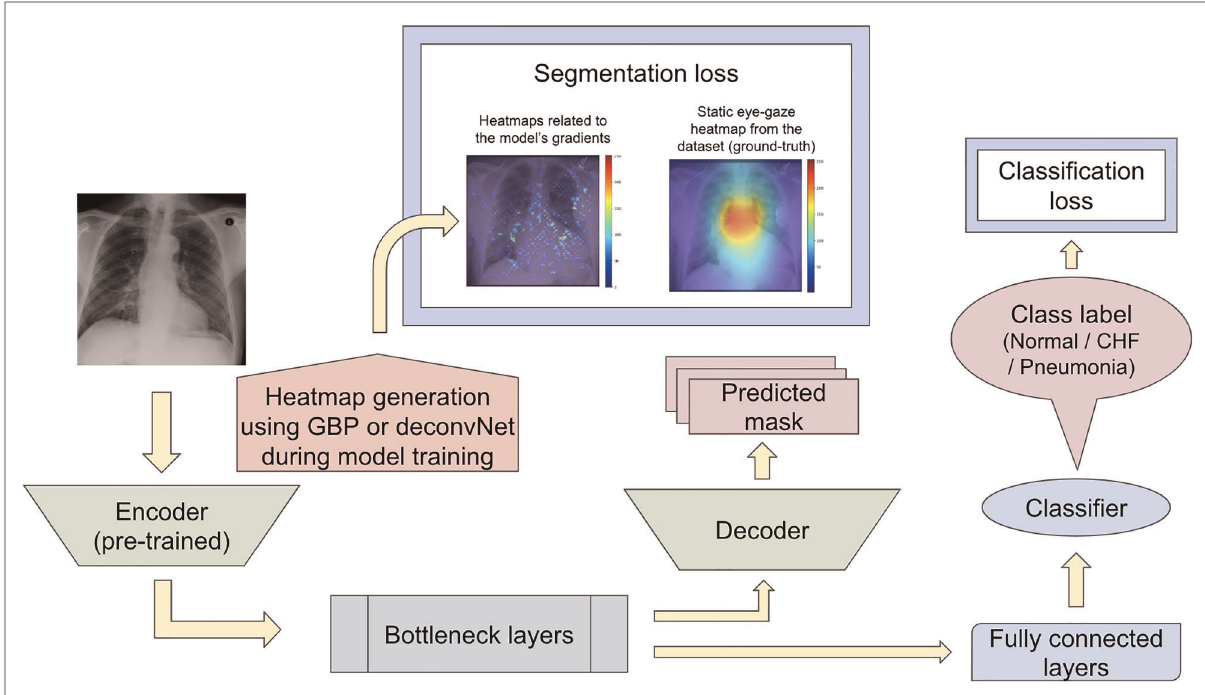
FIGURE 6 Model architecture for the proposed model set 1 with the segmentation loss computed based on derived heatmaps using either GBP or deconvNet and the static eye-gaze ground truth heatmaps from the